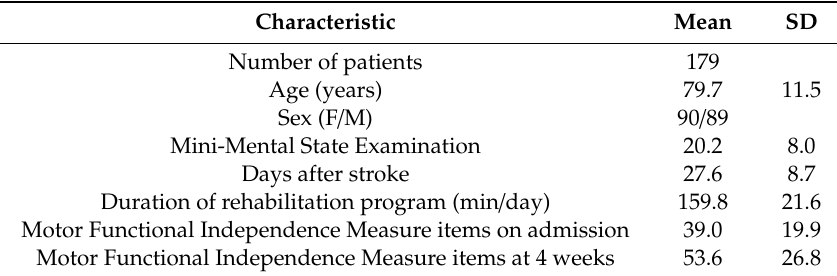
Table 1. Characteristics of the study